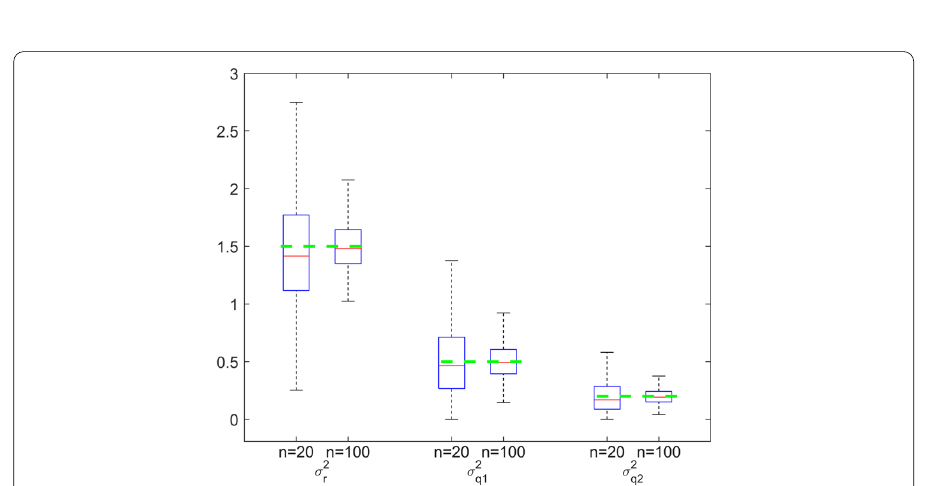
Fig. 8 Effect of data size n used on the quality of the proposed variance estimates with the linear vehicle motion model. Horizontal dashed lines show the true variances